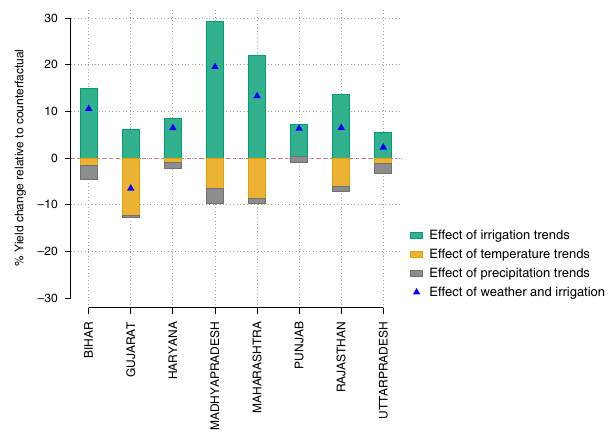
Fig. 3 Breakdown of changes in wheat yield from irrigation and weather in 2000-09 in the major wheat-producing states. Green bars represent the percent of yield that is gained due to irrigation. Orange and gray bars represent the percent of yield that is lost due to temperature and precipitation respectively. For each state, the fi gure shows how far predicted yields generated from the Full Model are from predicted yields generated when (i) Irrigation is kept at average 1970 – 71 values; green bars (ii) Temperature variables are kept at average 1970 – 71 values; orange bars (iii) Precipitation variables are kept at average 1970 – 71 values; gray bars or (iii) Irrigation as well as weather variables are kept at average 1970 – 71 values; blue triangles. Source data are provided as a Source